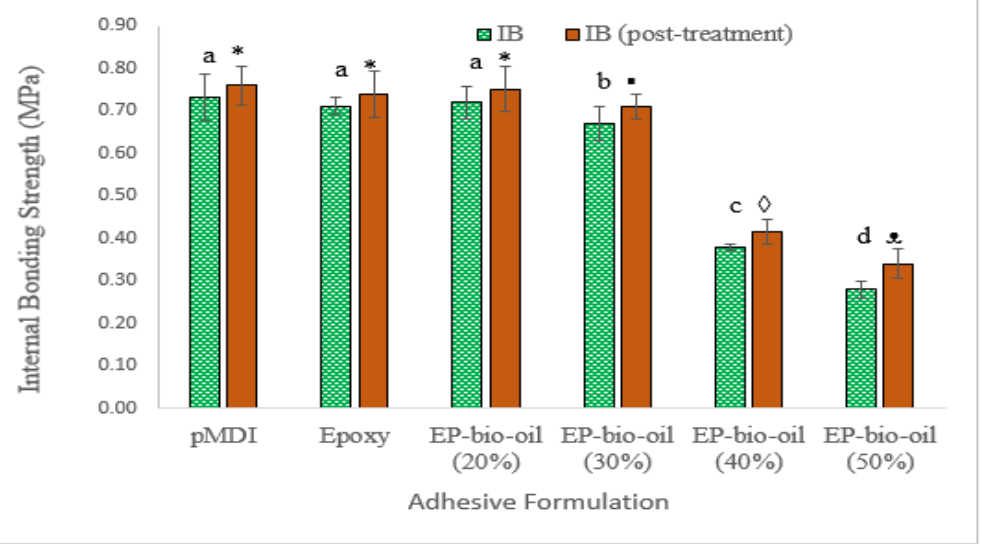
Figure 7. Internal bond strength of OSB bonded with the epoxy and epoxy-substituted bio-oil at 20%, 30%, 40%, and 50% bio-oil contents. EP-bio-oil (%): epoxy resin substituted with bio-oil. Different letters and symbols on the bar represent significant IB ( p < 0.05). Post-treated means were analyzed separately. Error bars represent standard deviation.